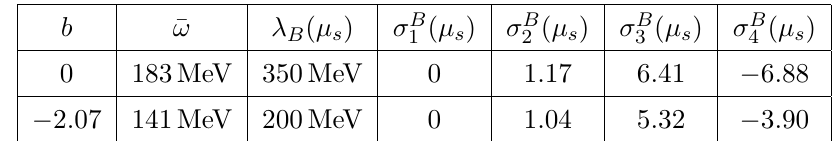
Table 1 . Parameters (left) and moments (right) of the model functions at the scale µ s = 1 GeV. It contains two free parameters, b and ω of the LCDA. The asymptotic behavior is φ B